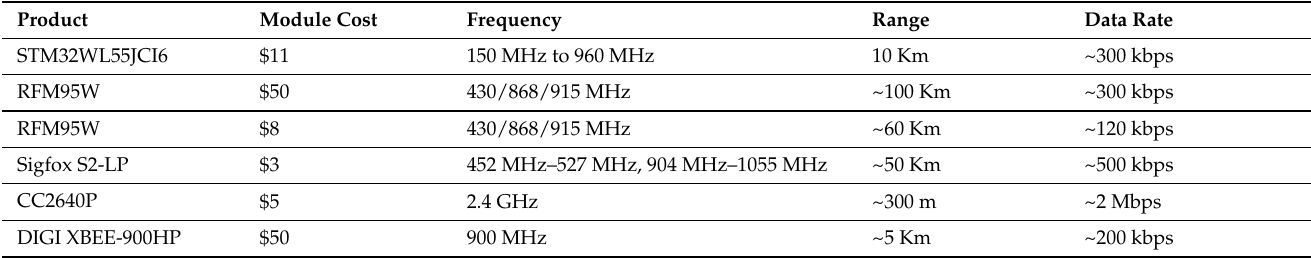
Table 3. Wireless radio technologies for IoT